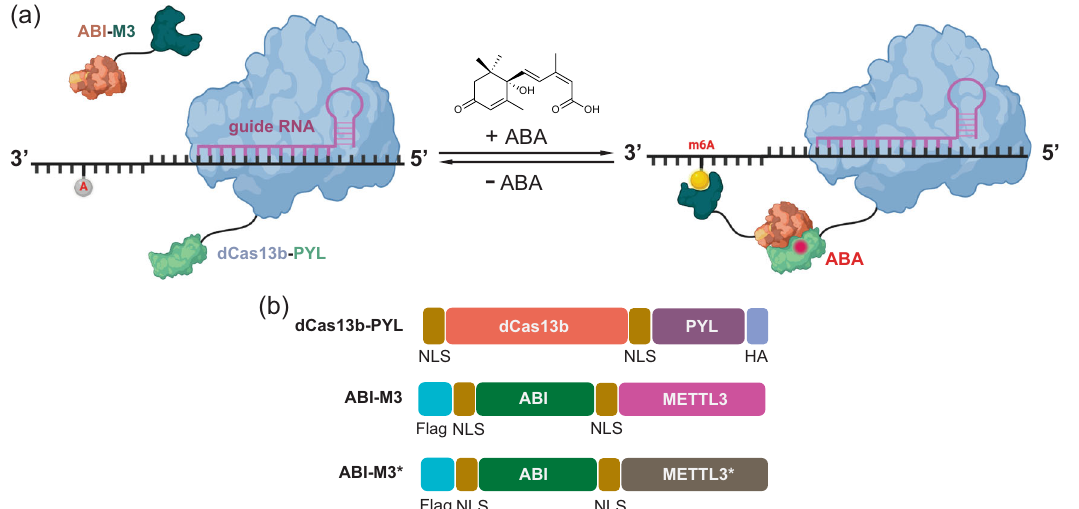
Fig. 1 The CIP/CRISPR-based inducible and reversible m 6 A writing platform. a dCas13b-PYL can be localized to the target adenosine site through gRNA. The presence of ABA induces the dimerization between PYL and ABI fusion proteins, which recruits ABI-M3 to the target locus for m 6 A writing. The induced m 6 A writing can be reversed by removing ABA and thus releases ABI-M3 from the RNA site. b DNA plasmids constructed for the inducible m 6 A writing system, expressing fusion proteins dCas13b-PYL, ABI-M3 (wide-type METTL3), and ABI-M3* (METTL3 D395A